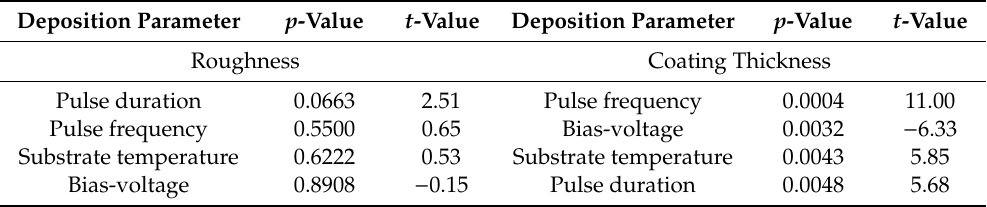
Table 2. Statistical evaluation of the e ff ects of the deposition parameters on di ff erent film properties using p - and t